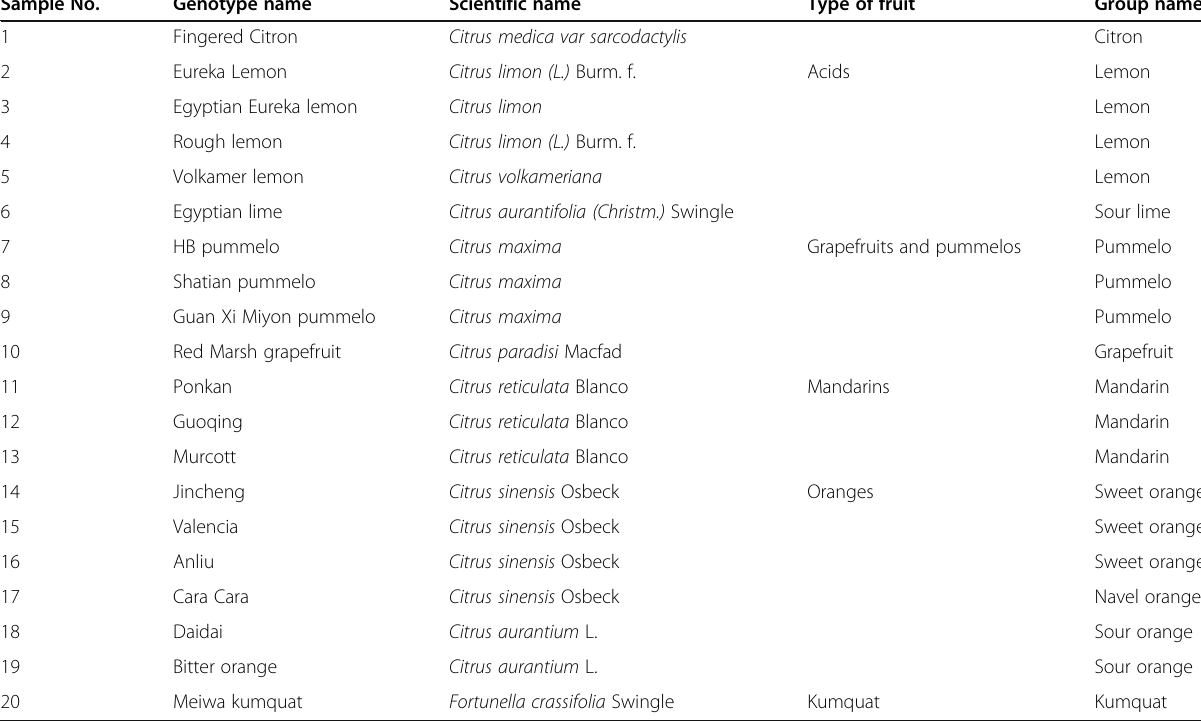
Table 1 The accession list of 20 citrus genotypes and its relatives used with SSR, LTR-IRAP and LTR-REMAP markers Sample